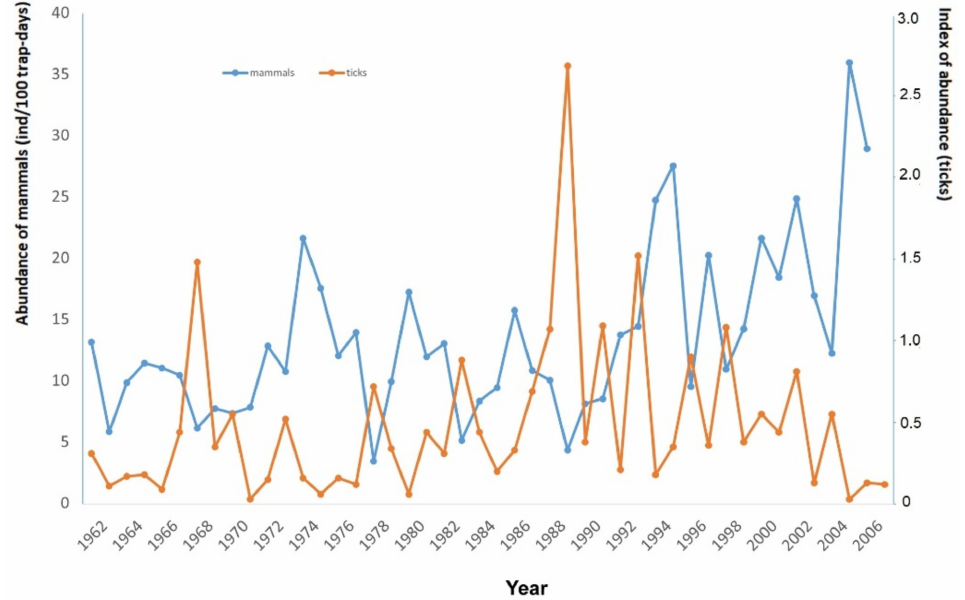
Figure 2. The dynamics of abundance of Ixodes apronophorus and its mammal hosts in West Siberia. Spectral analysis of the timeseries shows that the abundance of small mammals in Tyumen Region shows two cycles of fluctuations, a shorter cycle, with a period of